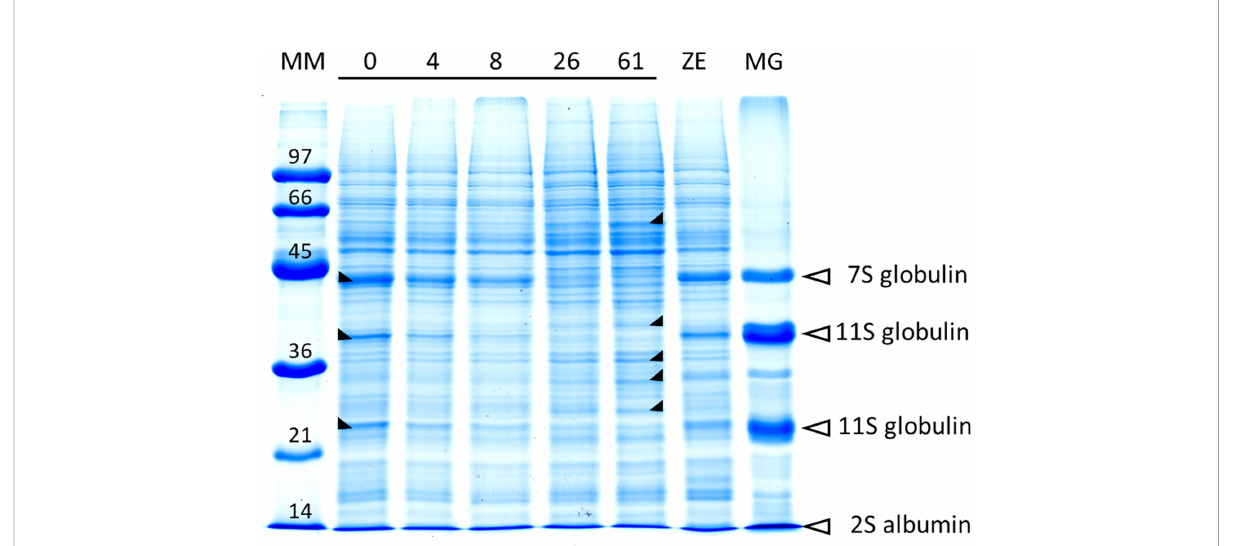
FIGURE 6 SDS-PAGE total protein pro fi le in somatic embryos (line 3,416) according to cold storage time (from 0 to 61 weeks), compared with the zygotic embryo (ZE) pro fi le. Molecular weights of protein markers (kDa) are given in the left-most line (MM). The location of major storage proteins in the protein pattern, given by the megagametophyte (MG) pro fi le, is indicated with arrows. The major modi fi cations of the protein abundances induced by the storage time are indicated on the corresponding bands by a black triangle ( y increase; x decrease).